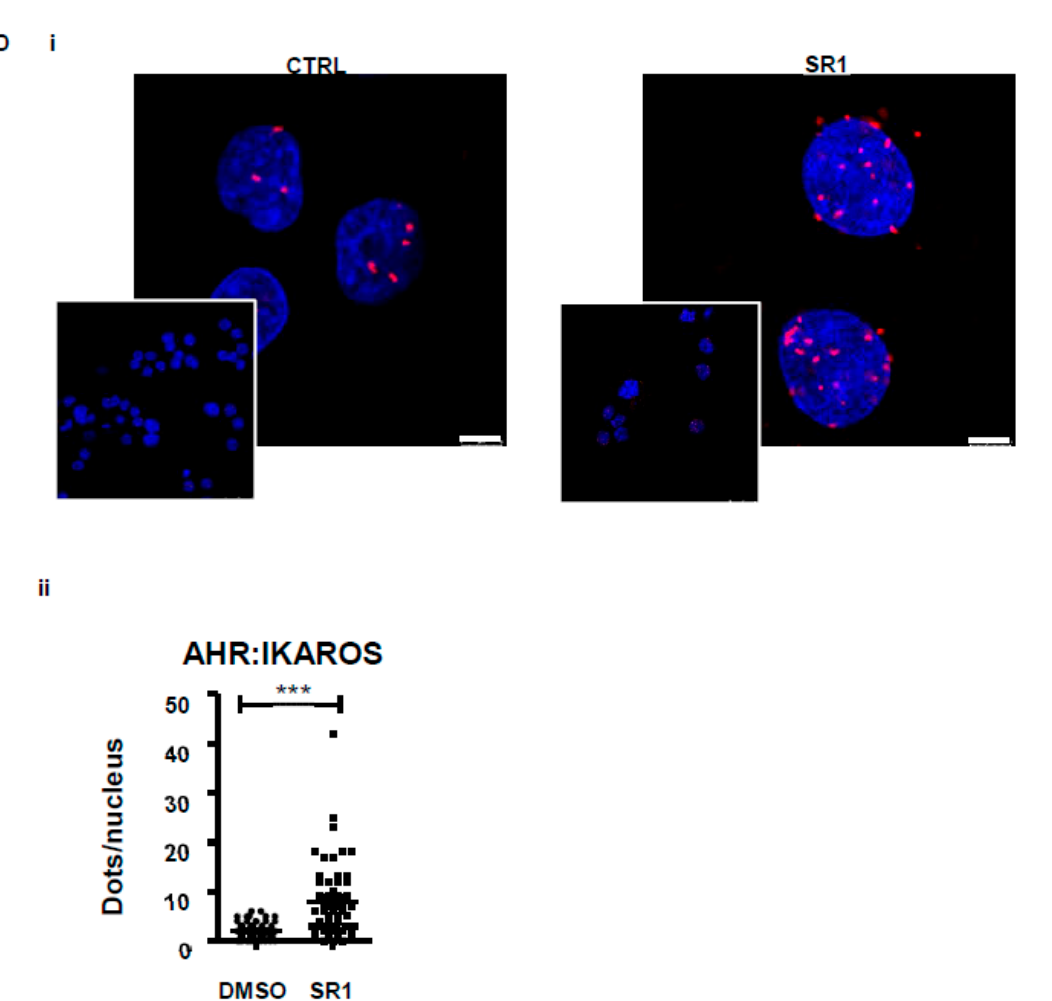
Figure 2. IKAROS: an actor of POI expansion. ( A ) Validation of shIKZF1 . CD34 + cells were prestimulated with CC220 cytokine cocktail for 24 h and transduced with vectors expressing shControl GFP or IKZF1-specific shRNA and differentiated into MK for 6 days in a serum free medium containing CC220 cytokine cocktail and SR1, at day 7 cells were washed and then cultured for 3 supplemental days with SR1 and TPO. At day 10, total RNA derived from sorted transduced cells expressing GFP was subjected to qRT-PCR. The bar graph represents the percentage of IKZF1 expression in cells at day 10 (68.7 ± 11.9% with sh scramble vs. 17.4 ± 1.4% with shIKZF1, the level of IKZF1 in NT cells has been arbitrary set at 100) (mean ± SEM, n = 3, ** p < 0.01, ns > 0.5, 1 way ANOVA and Bonferroni post test) ( B ) shIKZF1-derived POI expansion . Bar graph representing the % of POI-derived shIKZF1 or sh scramble transduced cells at day 10 (39.1 ± 2.1% POI with sh scramble vs. 12.5 ± 0.7% POI with shIKZF1) (mean ± SEM, n = 3, *** p < 0.001, Student t test) ( C ) Effect of Lenalidomide (LenaL) on POI expansion . CD34 + cells were cultured for 7 days in serum free medium in presence of SR1 and CC220 cytokine cocktail. At day 7, cells were washed and cultured for 3 supplemental days with TPO and SR1. LenaL was added at increasing concentrations (0.1 µM, 1 µM and 10 µM) at day 0 and again at day 7. (i) Bar graphs representing percentage of IKAROS-positive cells in POI (21.4 ± 4.1 with LenaL 0.1 µM vs 17.5 ± 2.6 with LenaL 1 µM 16.1 ± 3.9 % with LenaL 10 µM) (mean ± SEM of three experiments; * p < 0.05, ** p < 0.01, 1 way ANOVA and a Dunnett post test). (ii) Bar graphs representing the number of platelets released per well (9.4 ± 2.1 × 10 5 vs 4.1 ± 1.5 × 10 5 , ns p > 0.05, n = 3 Student t test) ( D ) (i) Representative images of the interaction between IKAROS and AHR in cells at day 10 examined by proximity ligation assay (PLA), where the interaction is visualized by red dots, scale bar: 5 µm. (ii) Dot plots representing the number of positive dots/nucleus in POI obtained in response to SR1 or in DMSO conditions. Positive signals were counted on eight images in 50 cells (7.8 ± 1.0 dots per POI with SR1 compared to 1.9 ± 0.2 dots in the control DMSO, n = 2, *** p < 0.001).